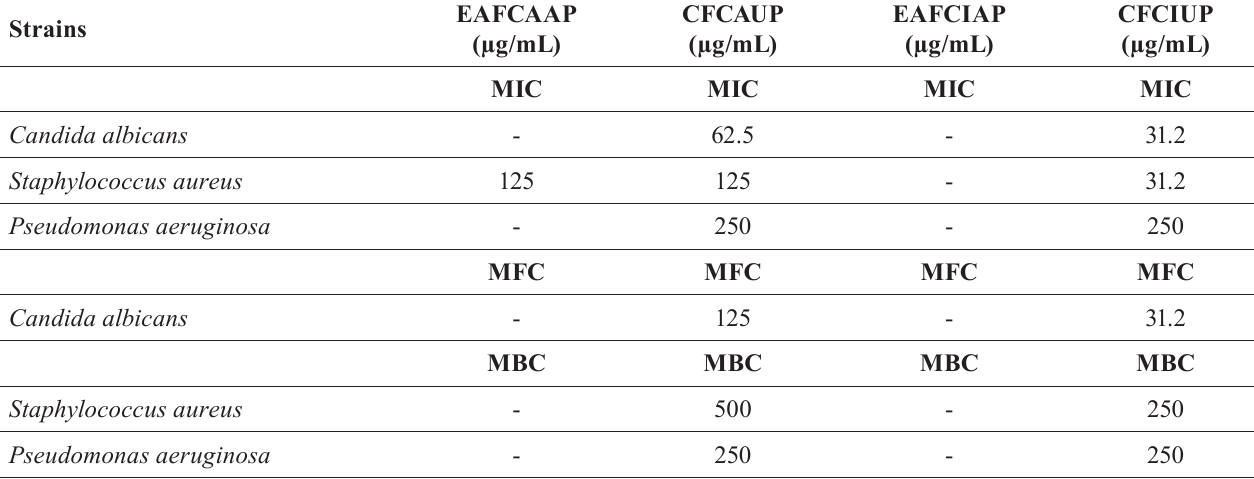
TABLE III - Determination of Minimum Inhibitory Concentration (MIC) and Minimum Bactericidal and Fungicidal Concentration (MBC and MFC) of the ethyl acetate and chloroform phases of the aerial and underground parts of Cyperus articulatus L. and Cyperus iria